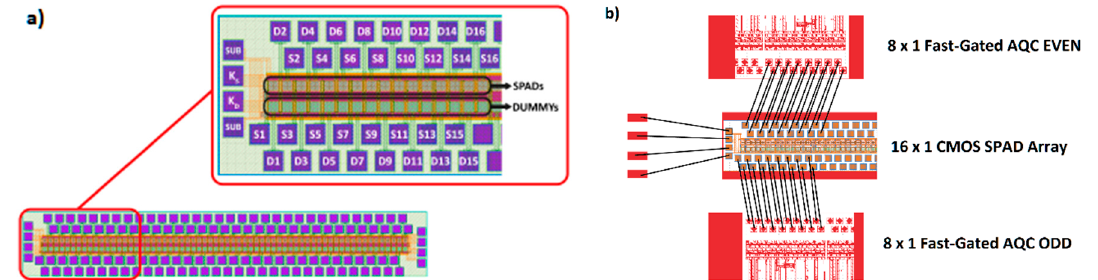
Figure 2. (a) Layout of the 64 × 1 SPAD array. SPAD and dummy contacts are placed at the top and bottom sides of the chip, whereas the common substrate and cathode contacts are placed on the left side. The inset shows a zoom of the 16 × 1 subset of the SPAD array adopted for the presented instrument. ( b ) Layout of the connections between the 16 × 1 Complementary Metal-Oxide-Semiconductor (CMOS) SPAD array and the two 8 × 1 fast-gating AQC arrays. The adoption of two different AQC arrays on both sides of the SPAD array allows the high fill-factor of the detector (~66%) to be exploited.